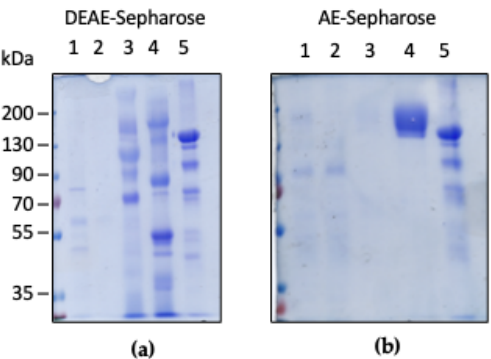
Figure 2. SDS-PAGE analysis of recombinant CP purified on DEAE-Sepharose ( a ) and AE-Sepharose ( b ). Panel ( a ): lane 1, input; lane 2, unbound fraction; lane 3, fraction eluted with NaCl 150 mM; lane 4, fraction eluted with NaCl 250 mM; lane 5, plasma-derived CP (5 μ g). Panel ( b ): lane 1, input; lane 2, unbound fraction; lane 3, fraction eluted with NaCl 250 mM; lane 4, fraction eluted with NaCl 500 mM (8 μ g); lane 5, plasma-derived CP (5 μ g).